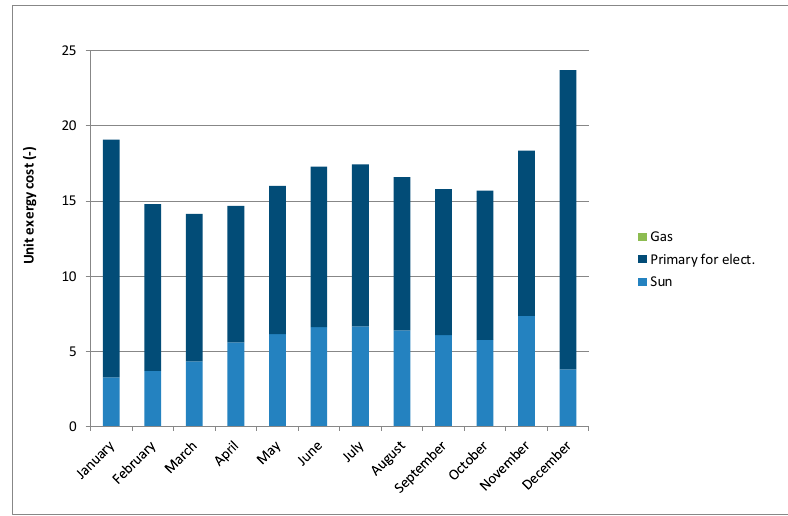
Figure A5. Secondary storage: Cost formation by source.